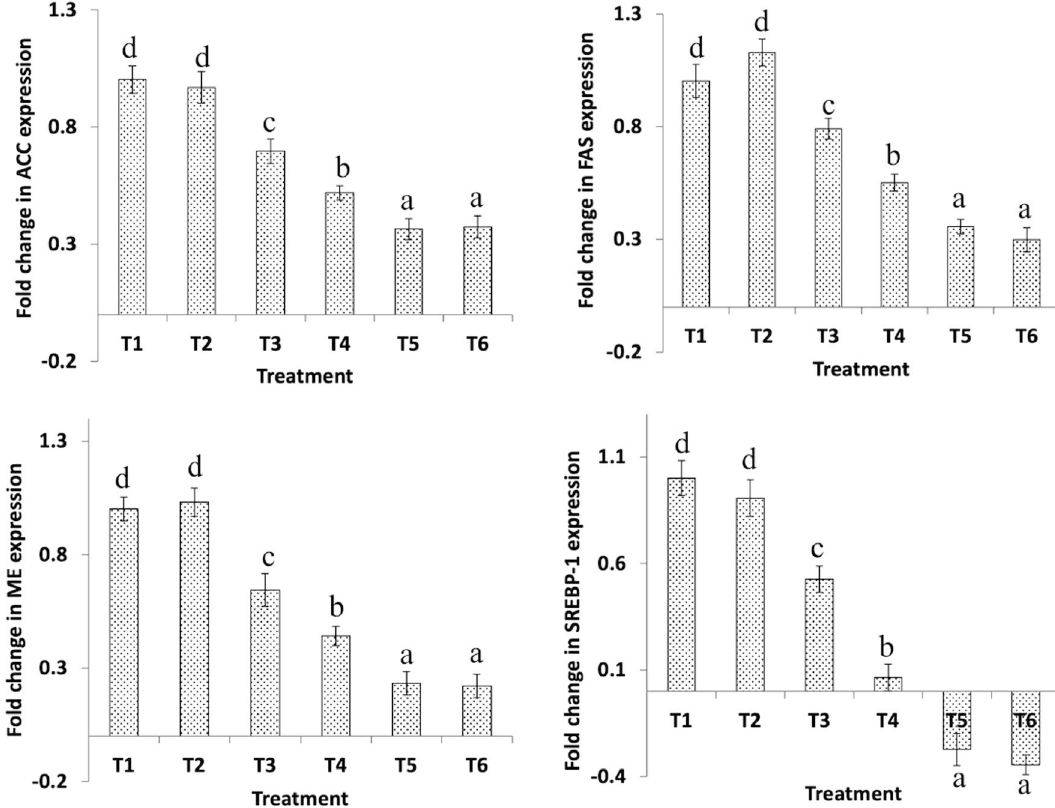
Figure 1. Effect of dietary B. Bifidum (BFD) and mannan-oligosaccharides (MOS) on hepatic ACC, FAS, ME, and SREBP-1 gene expression in 21 days old broiler chicken. T 1 (no BFD/MOS/BMD), T 2 (20 mg BMD/kg diet), T 3 (0.1% MOS + 10 6 cfu BFD/g feed), T 4 (0.1% MOS + 10 7 cfu BFD/g feed), T 5 (0.2% MOS + 10 6 cfu BFD/g feed), T 6 (0.2% MOS + 10 7 cfu BFD/g feed). Results are presented as means ± SEM with six birds per treatment. Means values with different superscripts letters differ significantly (P <